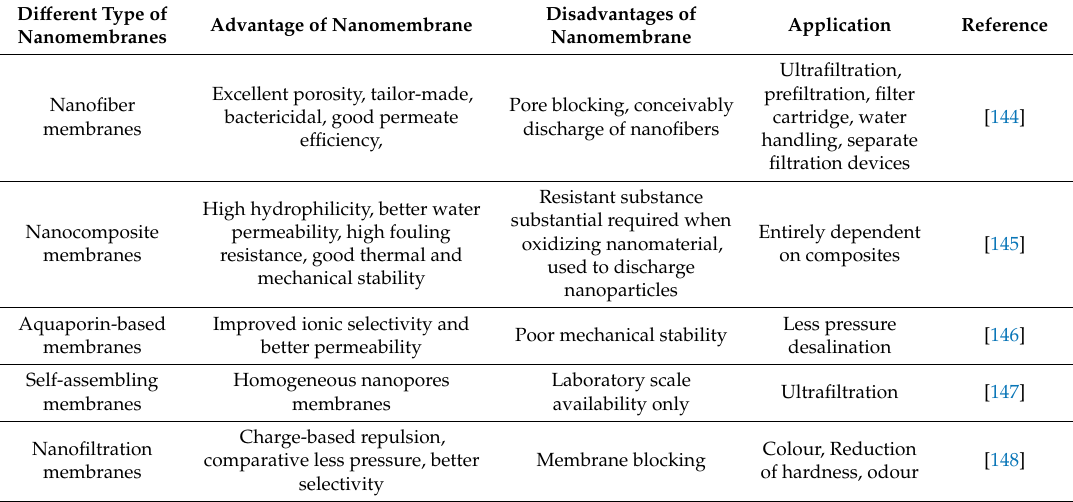
Table 4. Advantages / disadvantages and applications of